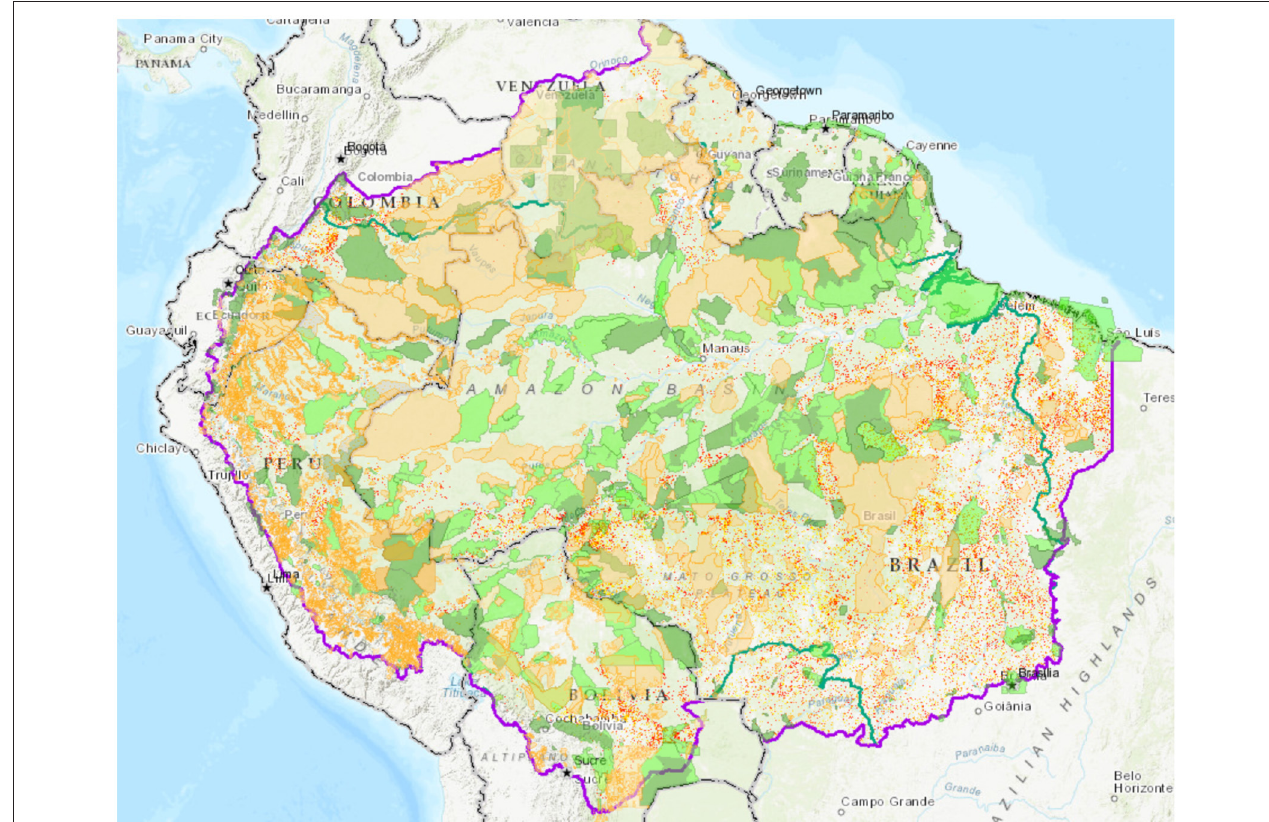
FIGURE 1 | Indigenous peoples’ territories and natural protected areas in the Amazon countries. Source: Red Amazónica de Información Socioambiental Georreferenciada (RAISG). https://www.amazoniasocioambiental.org/es/mapas/. Reproduced with permission.